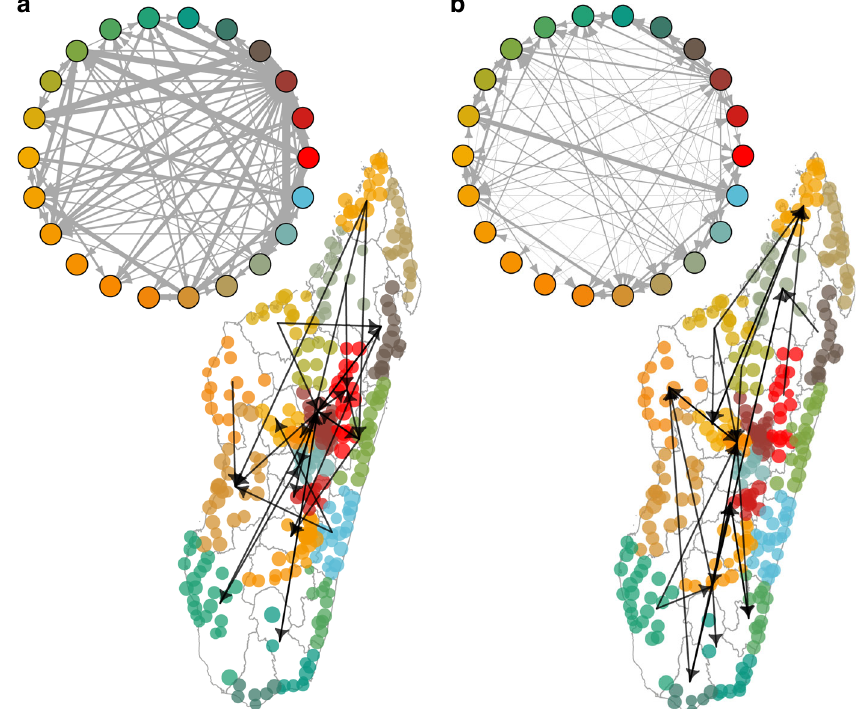
Fig. 3 The travel and parasite importation networks. a The travel network between regions and top routes of travel between communes ( N = 367 communes, colored by region as in Fig. 2). Parasite network importations with the top quantile of trips. b The top destinations for parasite importation included Atsinanana (East coast), Menabe (West coast), and Vatovay Fitovinany (East Coast), all regions located nearby the capital region